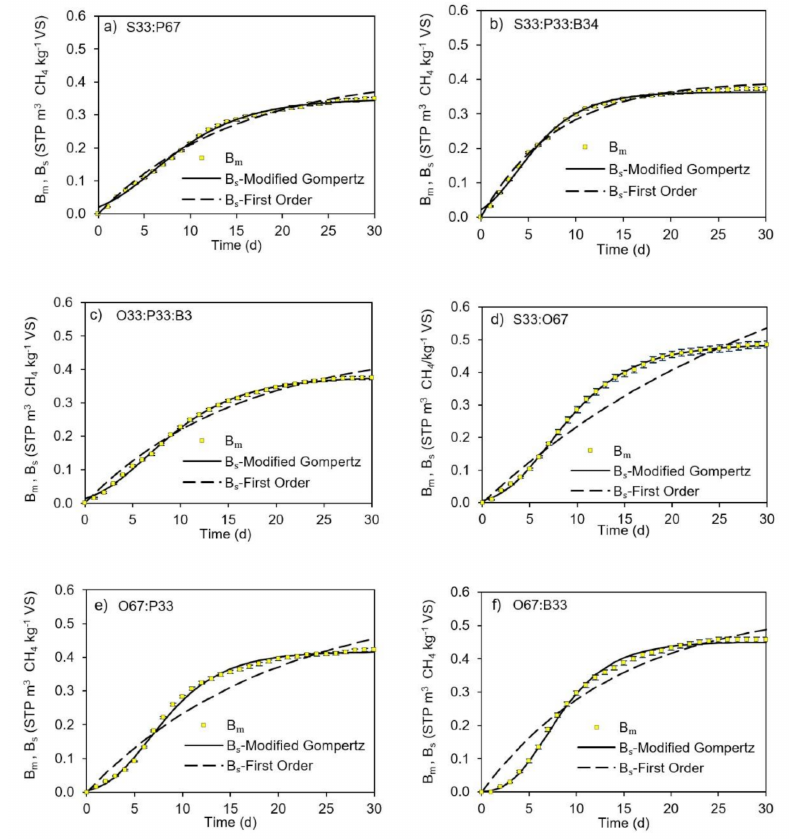
Figure 4. Accumulative CH 4 production from experimental data (B m ) and calibrated model (B s ) of the mixtures with the smallest deviations ( a – c ) and the greatest deviations ( d – f ) from the first-order model. The letter represents the waste stream (S: slaughter wastewater; O: offal wastewater; P: paunch wastewater; B: bovine manure) and the number its %VS in the